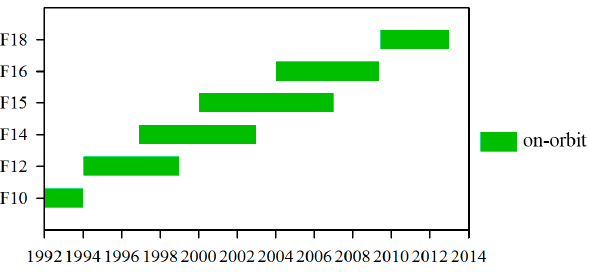
Figure 2. DMSP/OLS nighttime light time-series satellite.